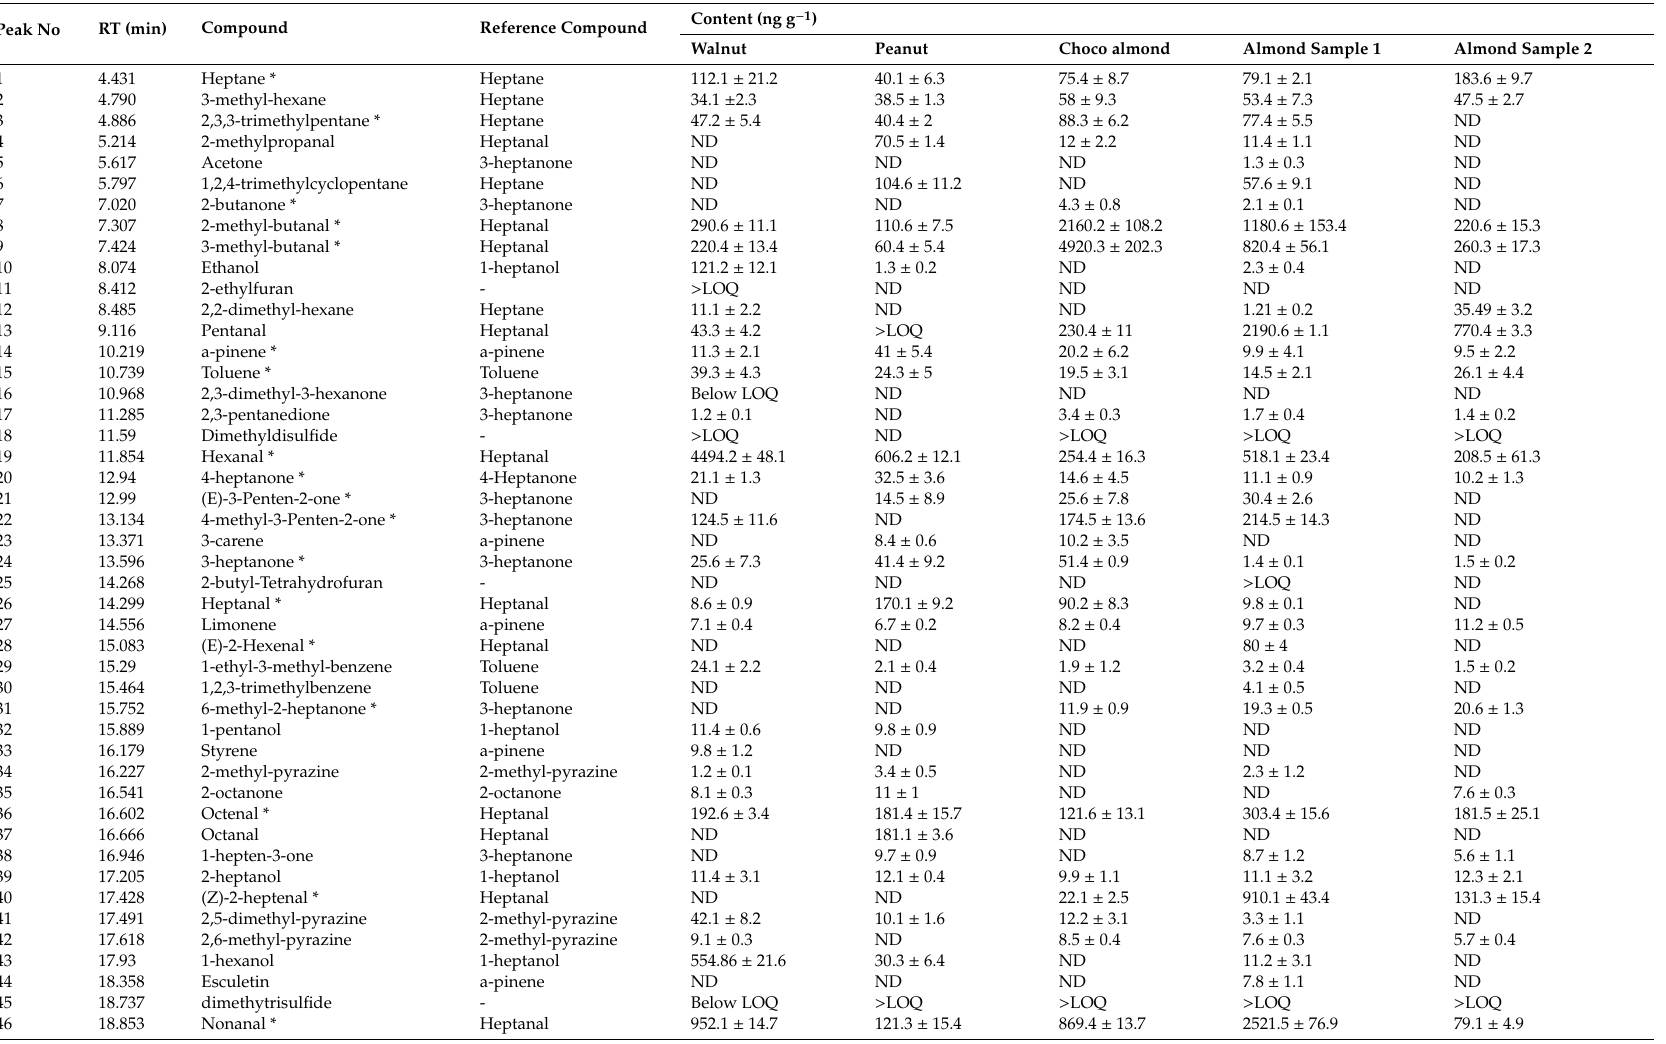
Table 3. Results obtained from commercial drink samples